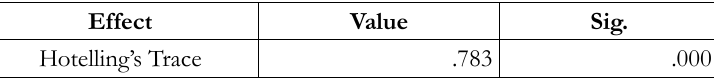
Table 7. Result of MANOVA test